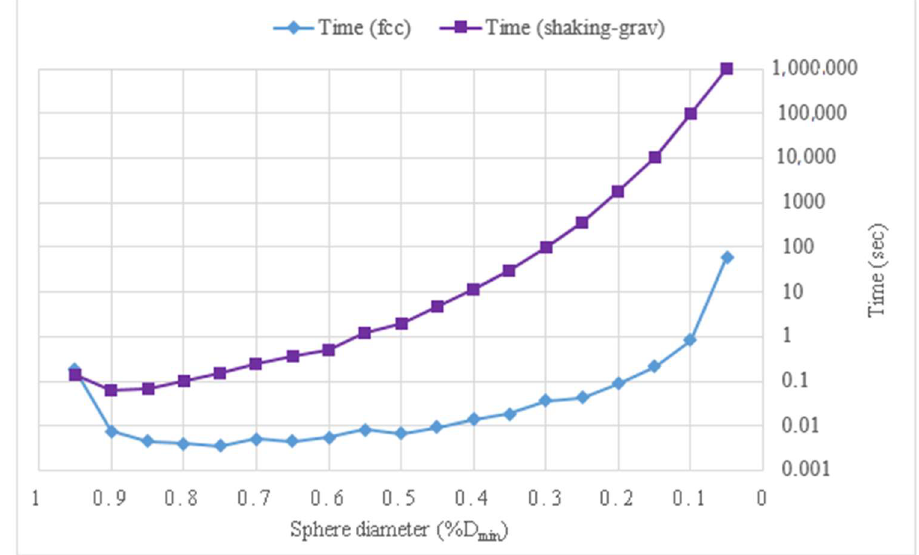
Figure 7. Comparison of the processing time in the model of a sinusoidal axisymmetric channel with D min /D max = 0.5.